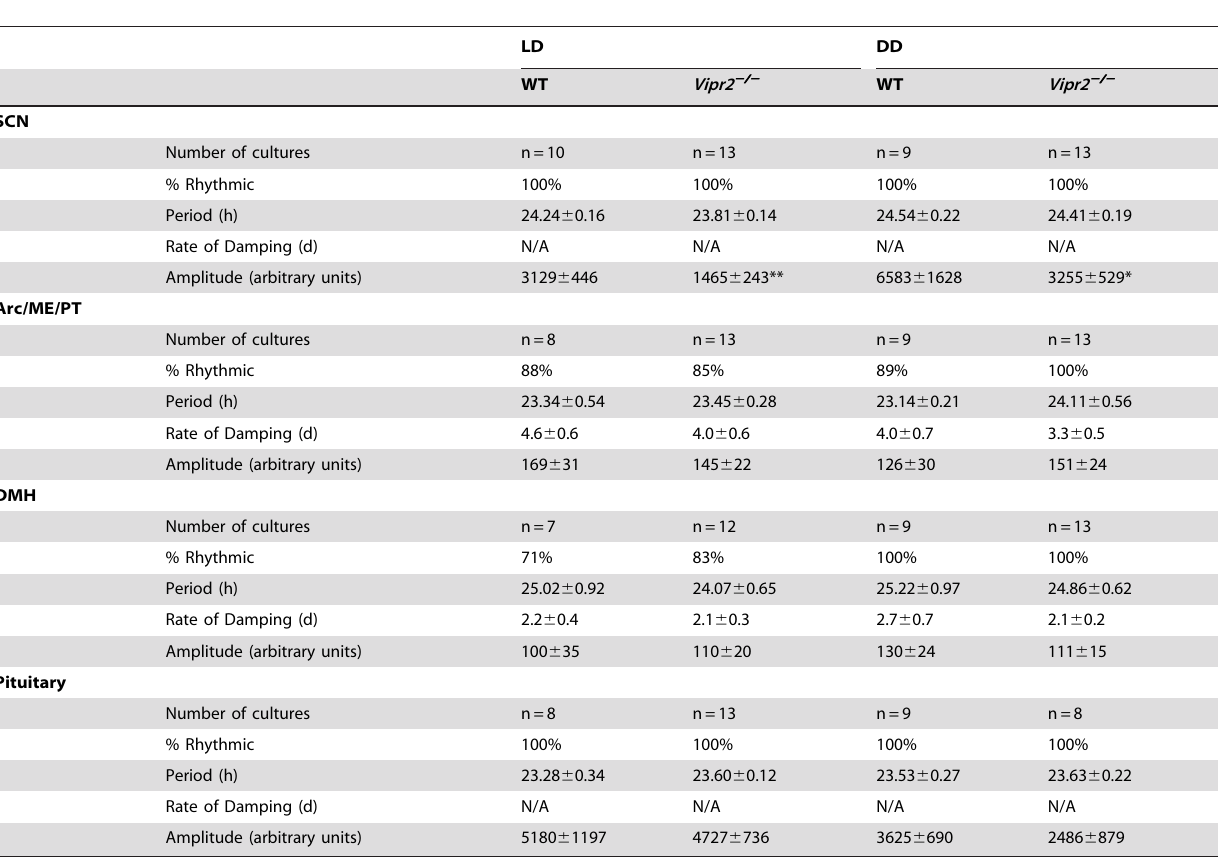
Table 1. Bioluminescence Data for Circadian Parameters of WT and Vipr2 2 / 2